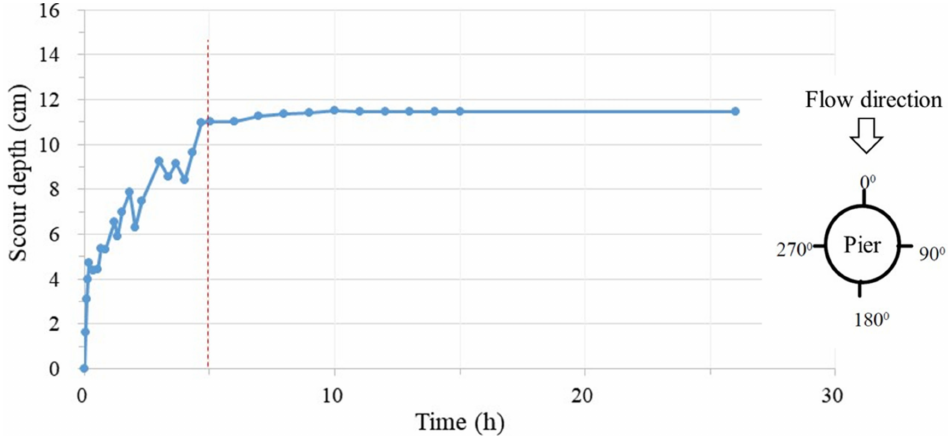
Figure 7. Evolution of scour depth at 0 ◦ of pier without CKAW (Case